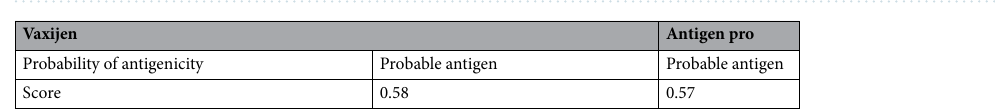
Table 2. Evaluation of antigenicity with two servers (Vaxijen and Antigen) show that leish 21 can activate the immune response.